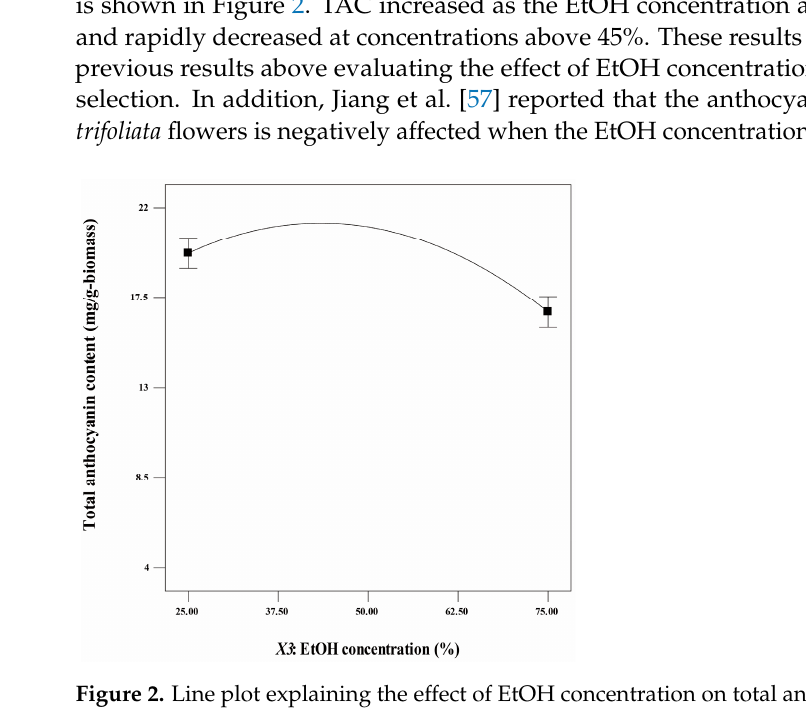
Table 4. Numerical optimization of anthocyanin extraction from elderberry.